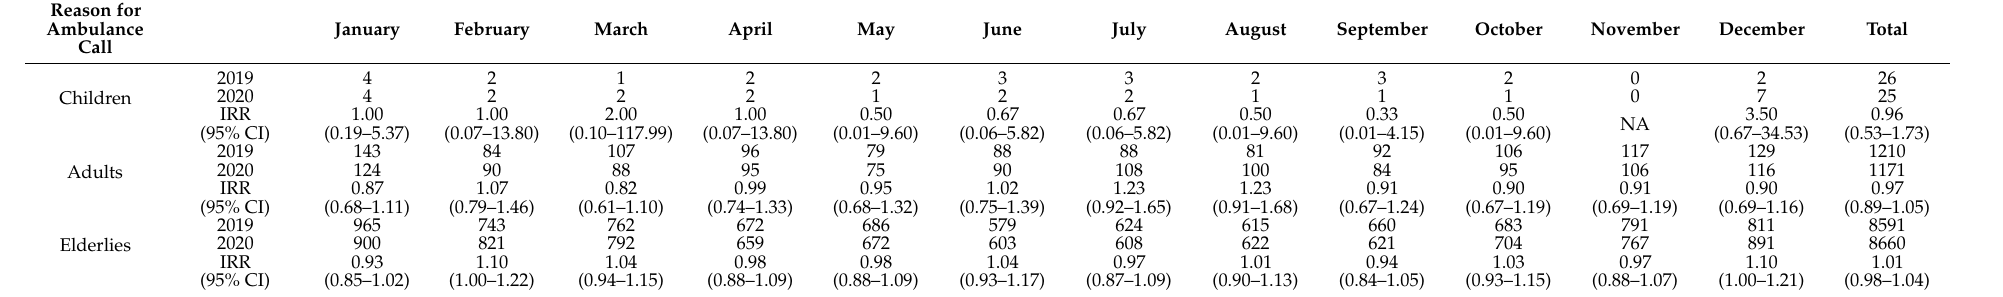
Table 6. The number of deaths among hospitalized emergency patients for acute disease registered in the Osaka Emergency Information Research Intelligent Operation Network system. Reason for Ambulance